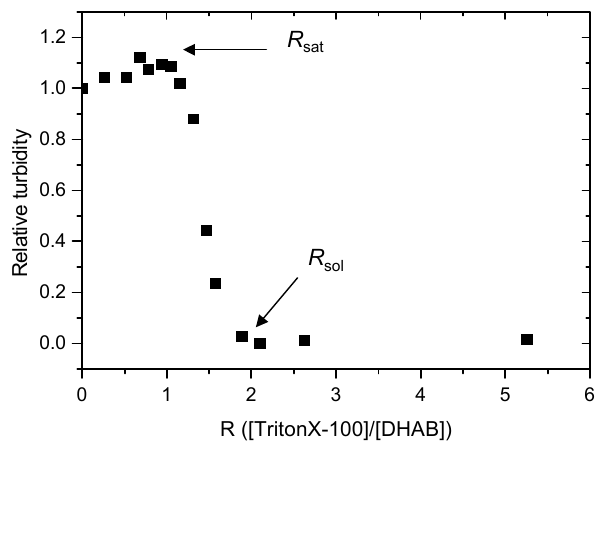
Figure 1. Example of a solubilisation